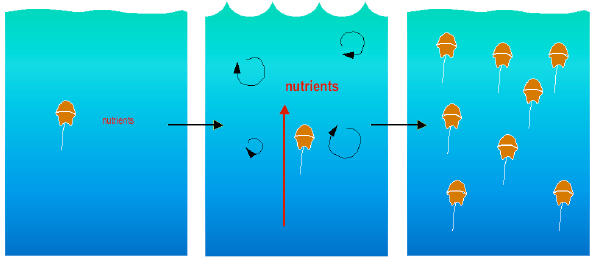
Fig. 4. Proposed conceptual mechanism to help explain the onset of some dinoflagellate blooms. Left panel: dinoflagellates are in low abundance limited by low concentration of nutrients. Central panel: a storm resuspends sediments in a coastal area increasing the level of nutrients in the water column. Dinoflagellates may be able to take these nutrients up but the division process and swimming ability is impaired. Right panel: once storm conditions subside, dinoflagellates are no longer division impaired and may produce a cell